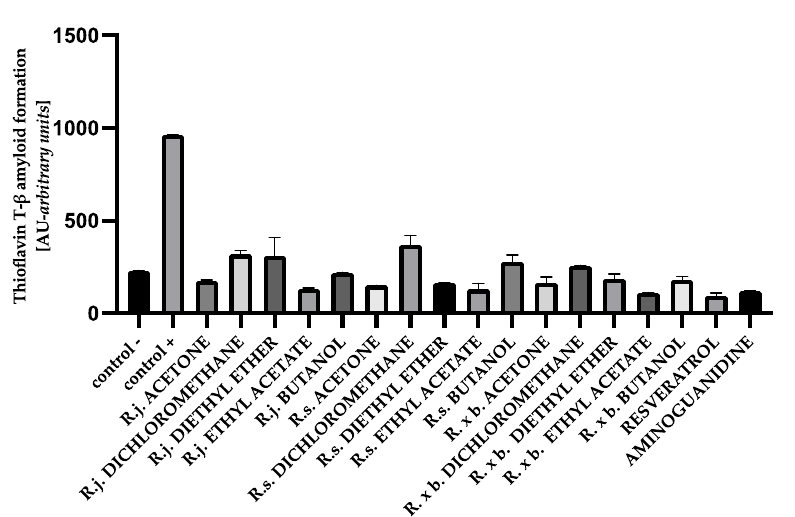
Figure 11. The effect of extracts and fractions on the in vitro formation of amyloid- β products—thioflavin T in HSA glycation. R.j., R.s., and R. × b. mean Reynoutria japonica , Reynoutria sachalinensis , and Reynoutria × bohemica , respectively. Error bars shown in this figure are means ± SD for n ≥ 5. All results were statistically significant at p ≤ 0.0001 compared to control +. Detailed information can be found in the Supplementary Material.